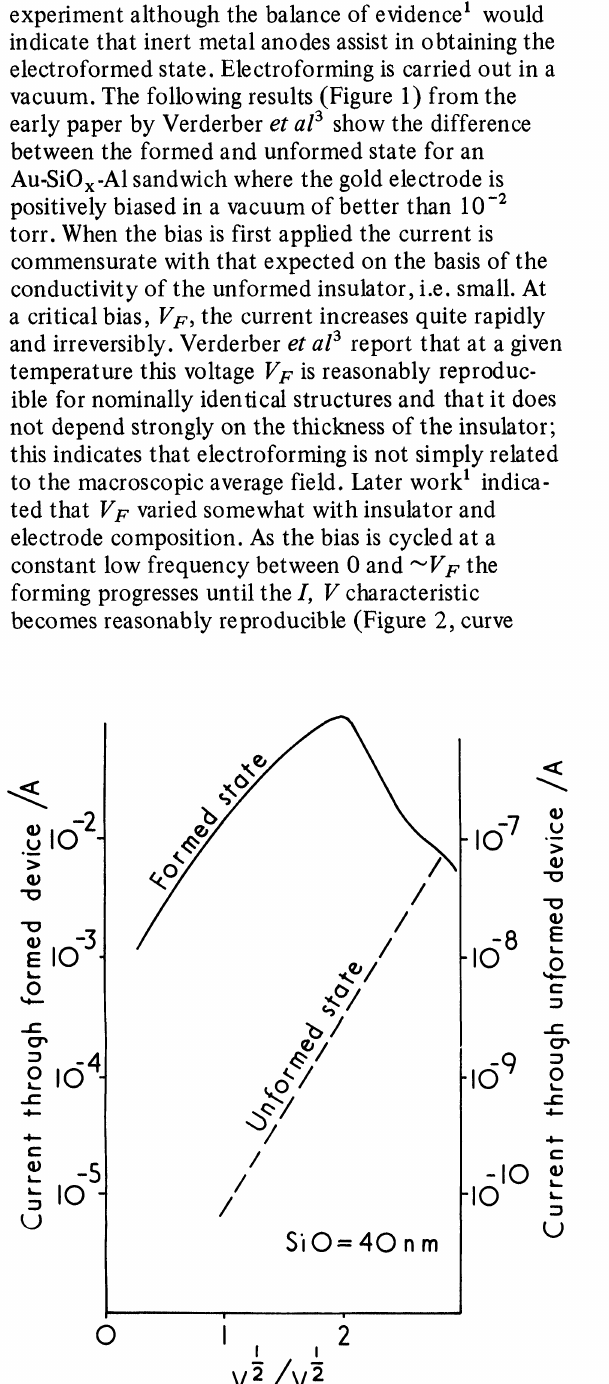
From Verderber et al. showing change in current upon electroforming A1-SiOx-Au.